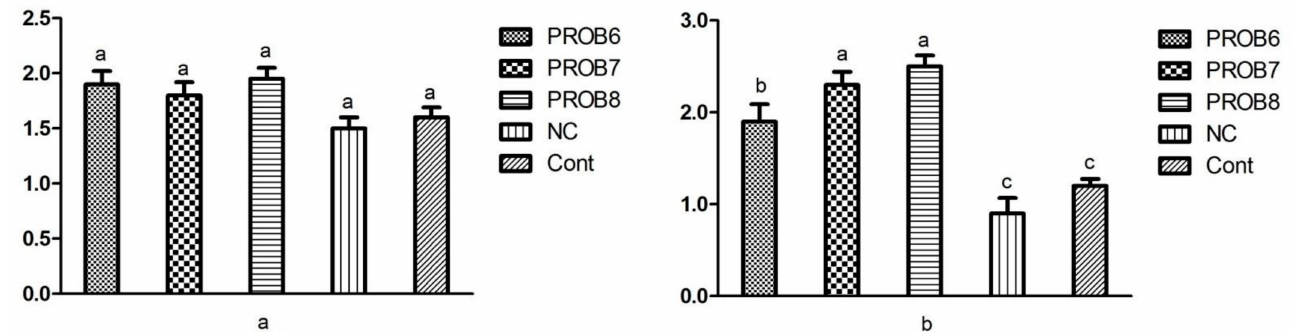
Figure 8. mRNA expression levels of tight junction proteins in different treatment groups: ( a ) CLDN 1 expression level; ( b ) ZO 1 expression level. Means with different superscripts (a, b, c) are significantly different ( p < 0.05). PROB6 = L. plantarum (1 × 10 6 CFU) supplemented group in feed; PROB7 = L. plantarum (1 × 10 7 CFU) supplemented group in feed; PROB8 = L. plantarum (1 × 10 8 CFU) supplemented group in feed; NC = infected, non-medicated treatment group; Cont = non-infected, non-medicated treated